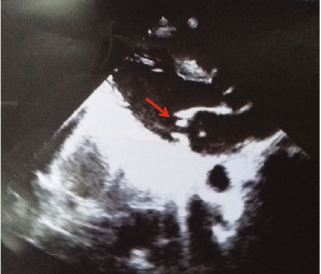
Figure 1: Transthoracic echocardiography; tiny 0 : 8 × 0 : 4 cm 2 vegetation attached to the anterior mitral lea fl et (arrow).